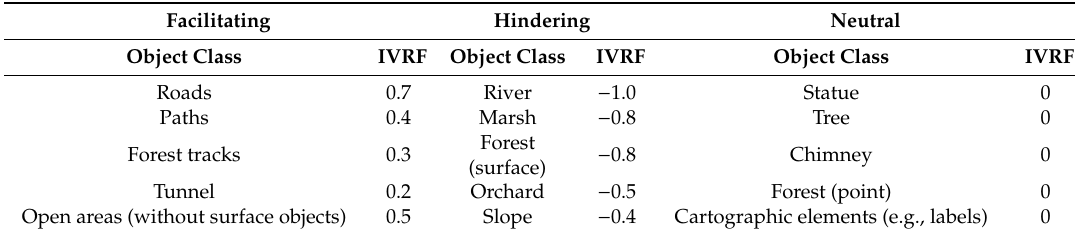
Table 1. Sample values of Vegetation Roughness Factor (VRF) coe ffi cients.